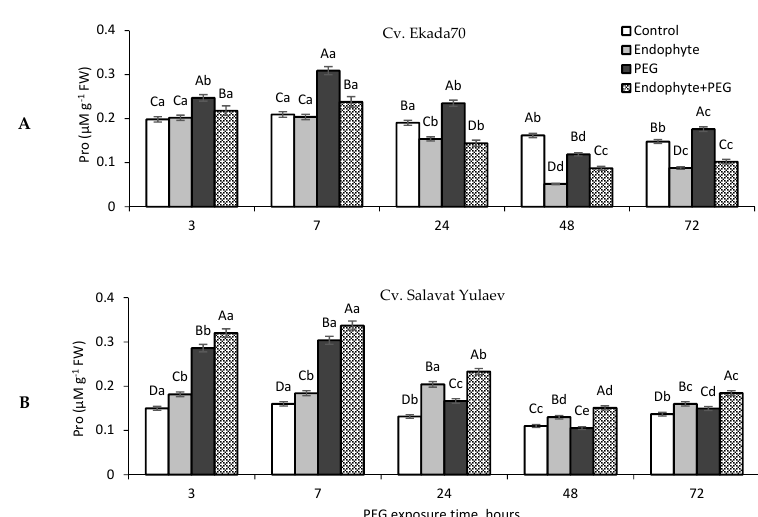
Figure 7. Changes in Proline (Pro) concentration in wheat seedlings (six days old) of cv. Ekada70 (drought-tolerant) ( A ) and cv. Salavat Yulaev (drought-sensitive) ( B ) primed with endophytic B. subtilis 10-4 (endophyte) and grown under normal and drought conditions (time of 12% PEG-6000 exposure are 3, 7, 24, 48, 72 h). Control—non-primed wheat seedlings grown under normal conditions; Endophyte—wheat seedlings primed with B. subtilis 10-4 and grown under normal conditions; PEG—non-primed wheat seedlings grown under drought (12% PEG-6000); Endophyte + PEG—wheat seedlings primed with B. subtilis 10-4 and grown under drought (12% PEG-6000). The bars are the means of three repetitions ± SEM. Different lowercase letters on top of the columns indicate that means for each treatment at different time points are different at p < 0.05. Different capital letters on top of the columns indicate that means for the same time point of various treatments are different at p < 0.05.